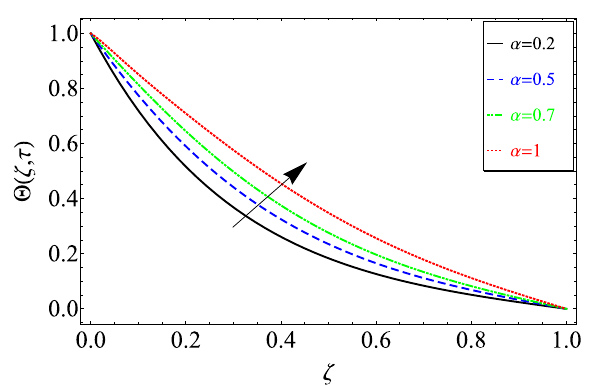
Figure 9. The effect of different values of α on temperature distribution of Maxwell nanofluid, when φ = 0.02 and Pr = 6300 .